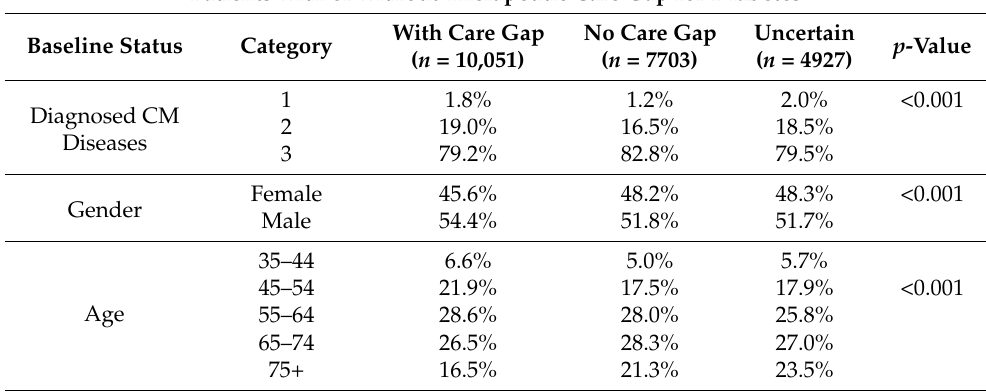
Table A4. Demographic and clinical characteristics of primary care patients 35+ years old who are included in care gap analysis for diabetes in Table